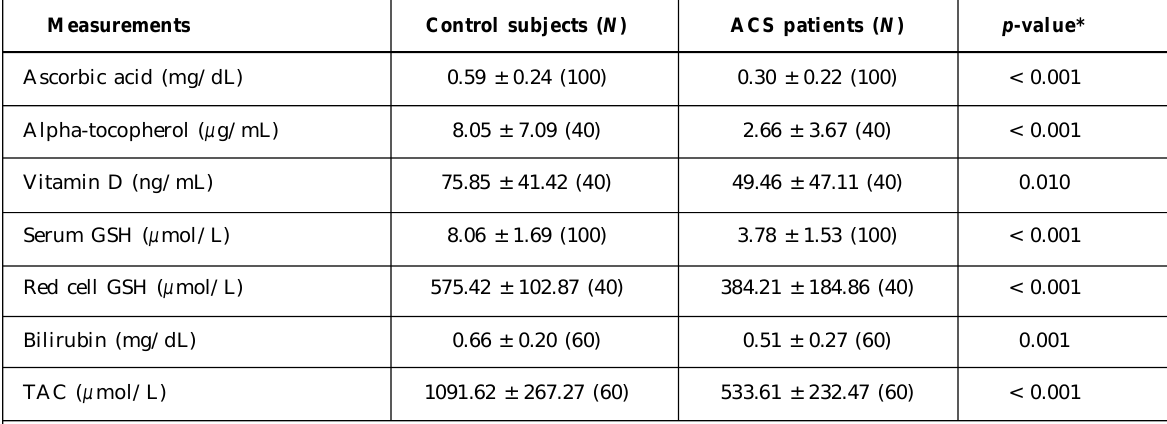
Table 3: Status of antioxidant defense systems in controls and ACS patients